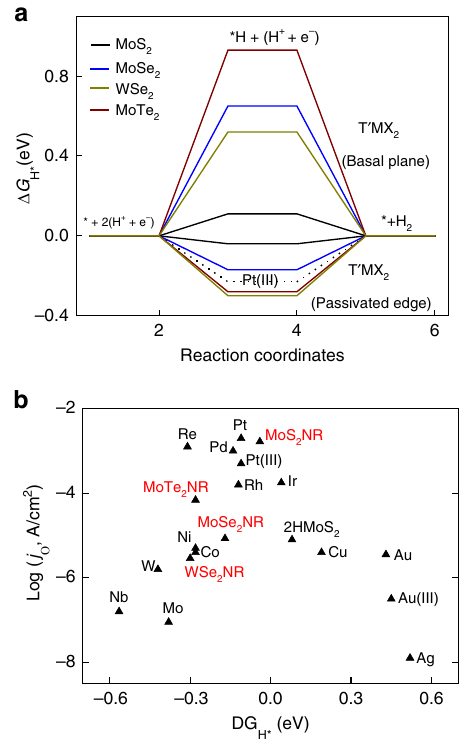
Fig. 5 Theoretical investigation of HER of MX 2 NRs. a Calculated Gibbs free energy diagram for hydrogen binding at the basal plane and edge sites of 1T ′ MX 2 systems at equilibrium potential (U = 0 V). b Volcano plot of the exchange current density vs. free energy for atomic hydrogen binding at MX 2 NRs and pure metal catalysts. Exchange current density of MX 2 NRs is normalized with the atomic site density of Pt for